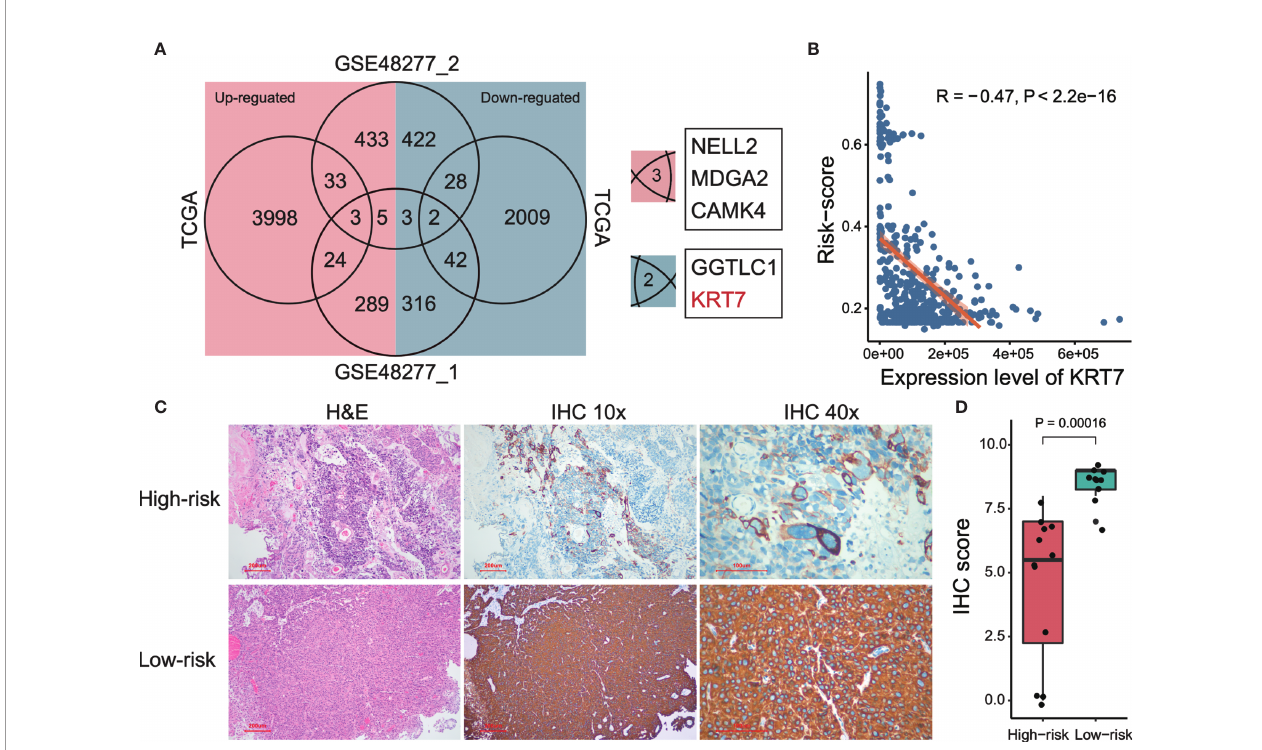
FIGURE 5 | Detection and validation of risk-related markers of MIBCs. (A) Venn plot shows the overlaps of differentially expressed genes among TCGA and two subsets of GSE48277. (B) Correlation between tumor risk score and expression level of KRT7. TCGA data was used to perform this analysis. Both Pearson correlation coef fi cient (R) and P-value were calculated. (C) Representative images of KRT7 IHC staining in different risk types and corresponding H&E staining. (D) KRT7 protein expression was signi fi cantly decreased in high-risk MIBC specimens compared with low-risk MIBC tissues by IHC. For the details of calculating IHC score, please see Materials and methods